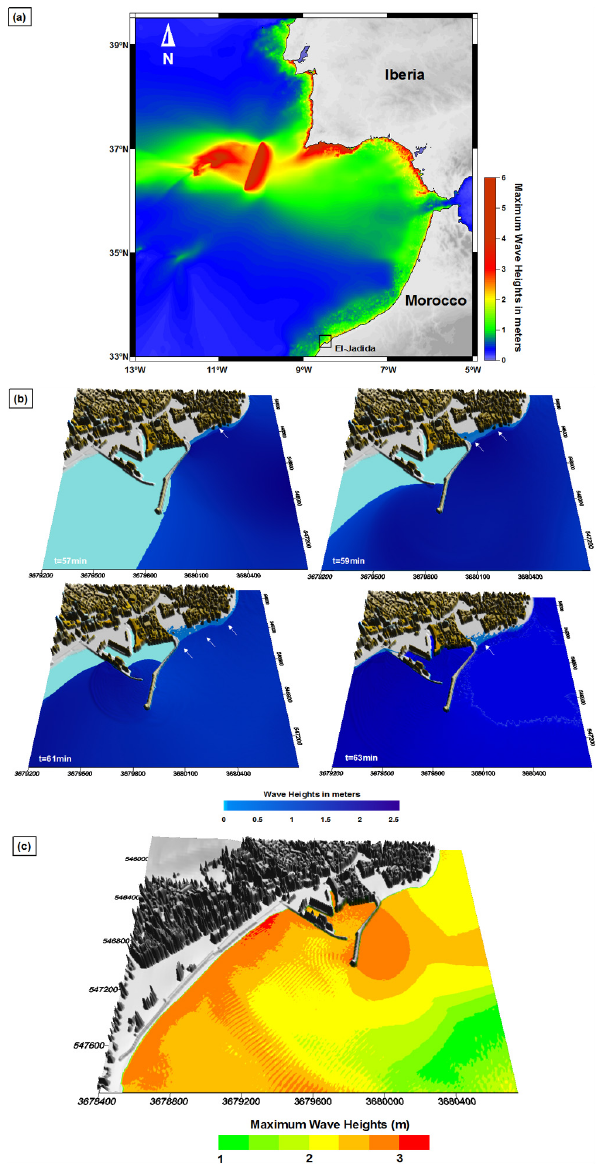
Fig. 7. Tsunami waves’ propagation and near-shore behaviour for the M w = 8 . 3 MP scenario: (a) regional tsunami energy patterns; (b) snapshots of near-shore tsunami propagation at El Jadida site; the white arrows indicate the overtopping locations; (c) maximum wave heights distribution near coasts and the harbour of the studied